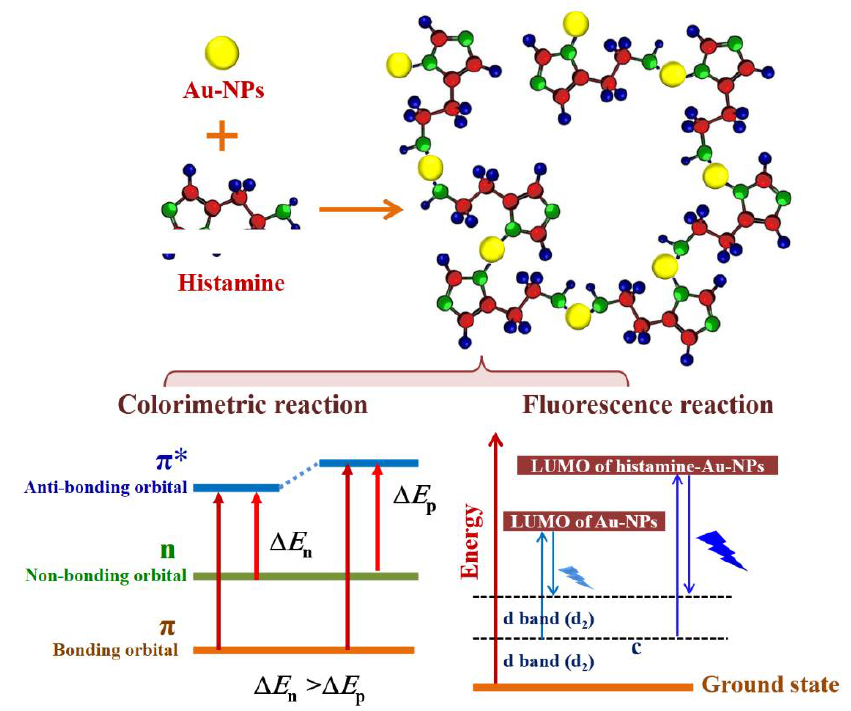
Scheme 1. Dual sensing mechanism for determination of histamine by Au-NPs.3.2. Analytical Performance of Au-NPs